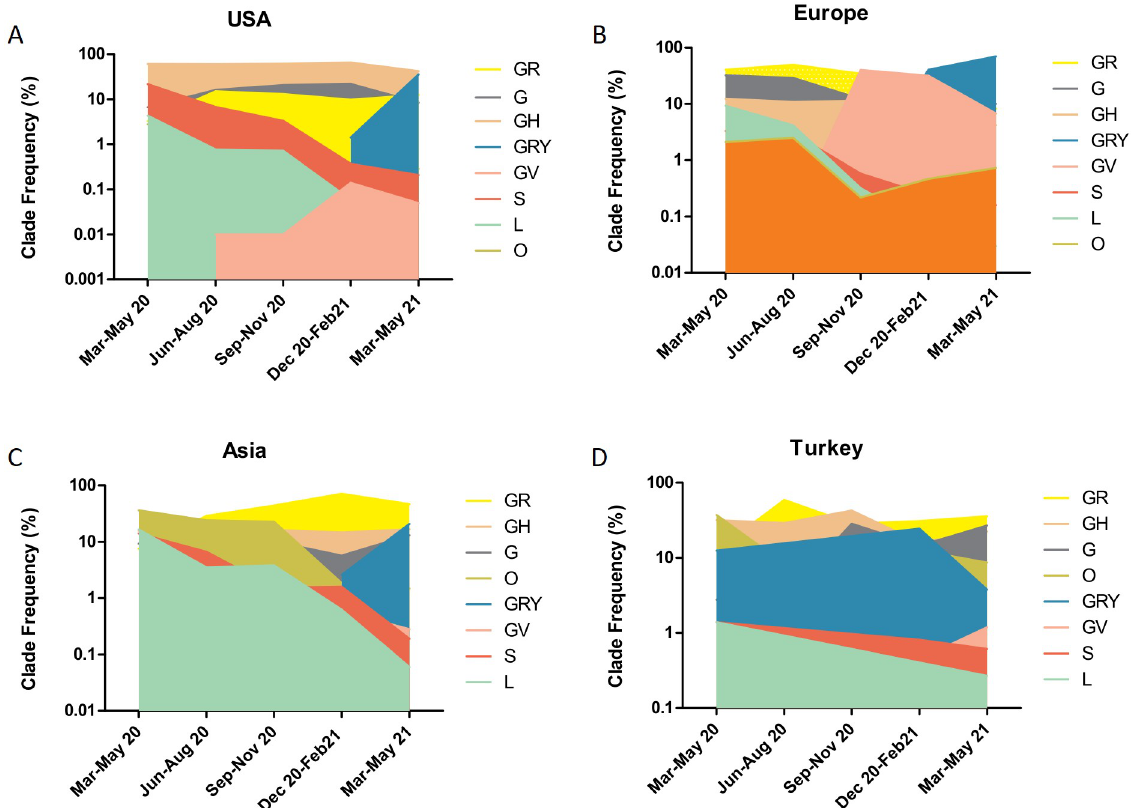
Fig 2. Clade distributions among different regions of the world. The distribution of seven different clades analyzed between March 2020-May 2021 divided into three months periods in A) USA, B) Europe, C) Asia, D) Turkey.